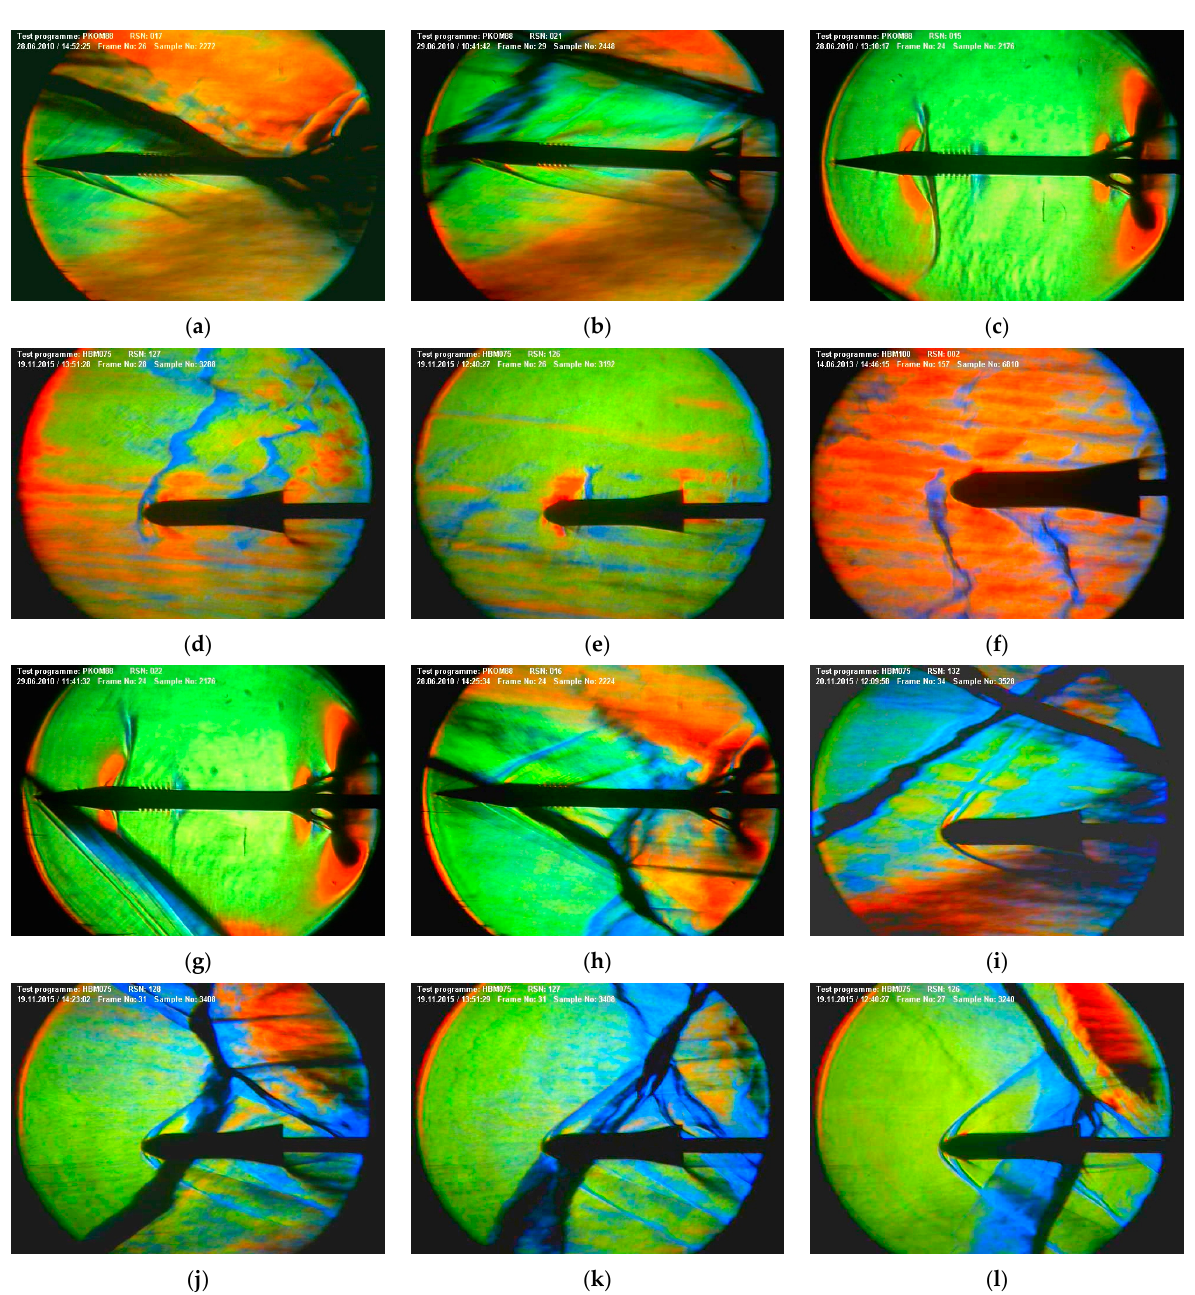
Figure 17. Schlieren visualizations of transient effects around the HB-2 standard model and a kinetic-energy projectile model in the T-38 wind tunnel: ( a , b ) establishment of supersonic flow on one side of the model only; ( c ) symmetric flow patterns with gradual increase of Mach number around the model; ( d – f ) normal shocks existing on one side of the model only; ( g – i ) large changes in flow directions along model length; ( h , j – l ) complex flow patterns created by several interacting shock waves.